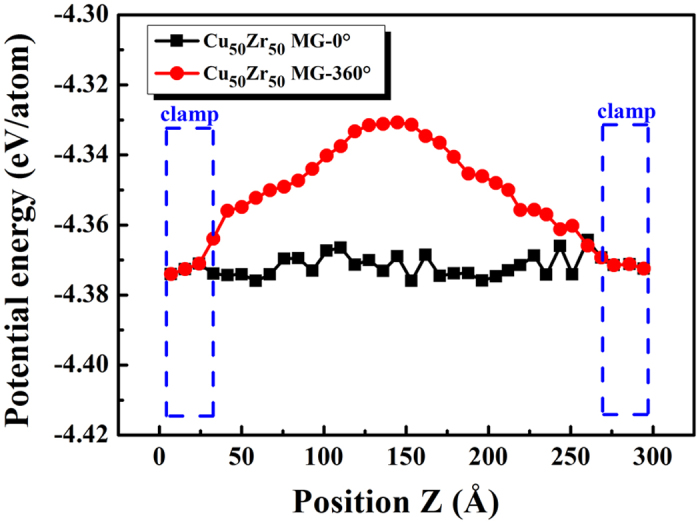
Change in potential energies of atoms of the Cu50Zr50 MG at TA = 0° and 360°.